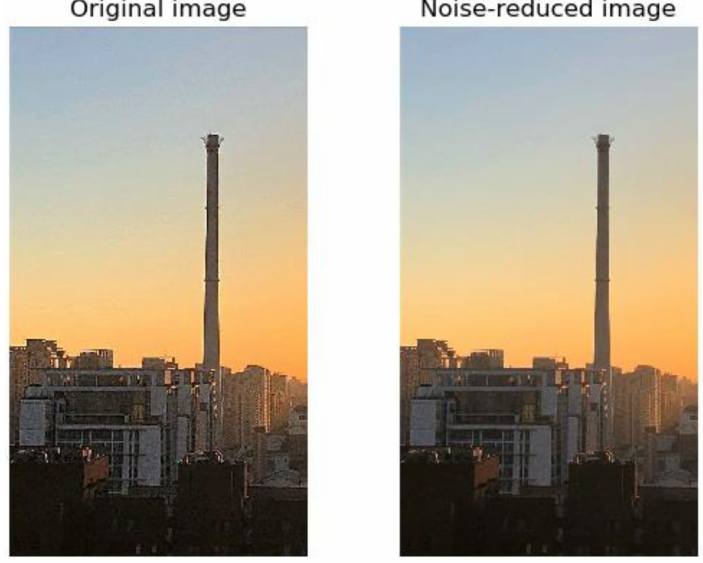
Figure 19. Image before and after noise